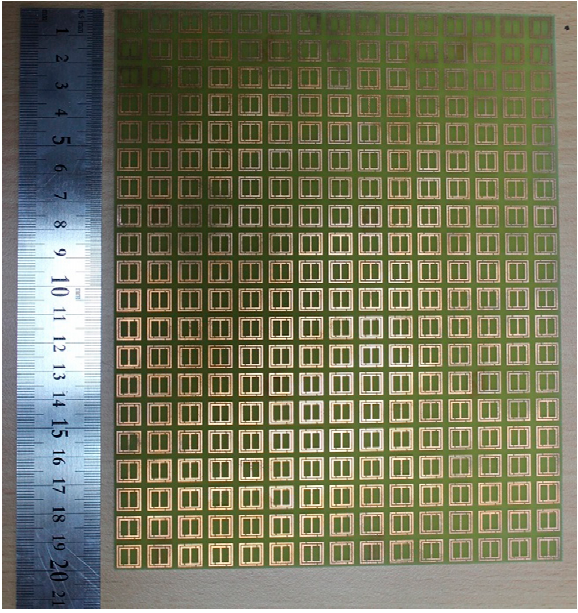
Figure 3. Fabricated 150 × 200-mm 2 (15 × 20 unit cells) array prototype of the proposed Figure 3. meta-atom structure.